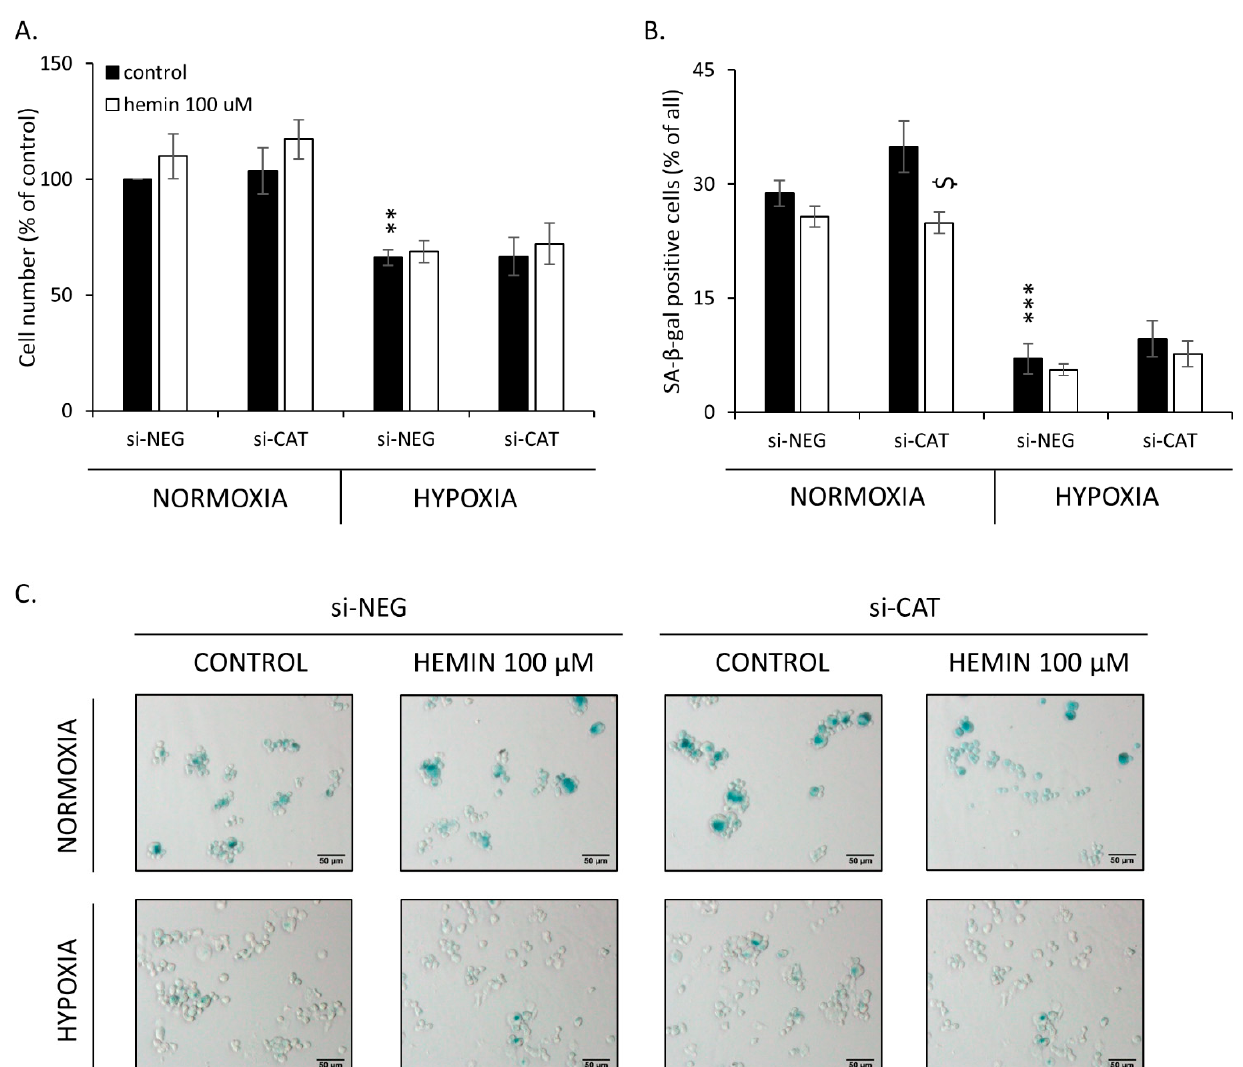
Figure 8. Hemin enhances escaping from senescence in hypoxic cells. In HCT116 cells, the gene encoding CAT was silenced with the use of siRNAs. Cells were cultured in parallel in normoxia or hypoxia. Cells were exposed to 100 µM hemin ( □ ). Control cells were subjected to IRINO and NaOH in the corresponding dose ( ■ ). ( A ) Evaluation of cell number. Cell number was counted with the use of Bürker’s chamber. ( B ) Evaluation of SA- β -gal positive cells; ( C ) Activity of SA- β -gal enzyme. Cells were cytospined and cytochemical staining for SA- β -gal activity was performed. Representative photos were acquired using light microscopy. Original magnification 200×, scale bar 50µM; Each bar represents mean ± SEM, n ≥ 3; ** p < 0.01, *** p < 0.001—vs. si-NEG control normoxia; $ p < 0.05—control vs. hemin 100 µM.